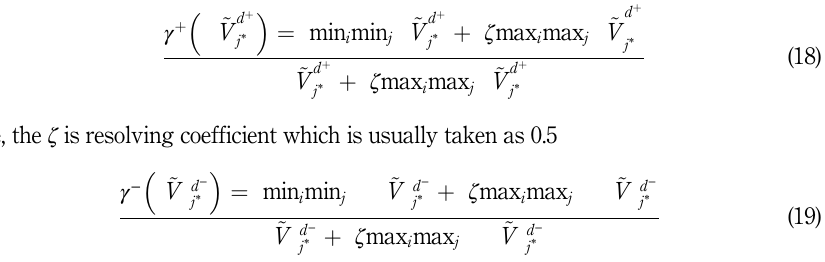
Step 9: The following equation is used to generate grey relational coefficient of individual alternative from FPIS and FNIS respectively.